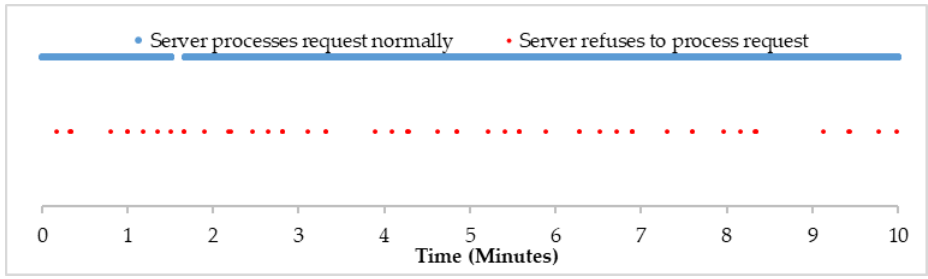
Figure 14. Time-series diagram of the login attempts of 8 server IP rotation.